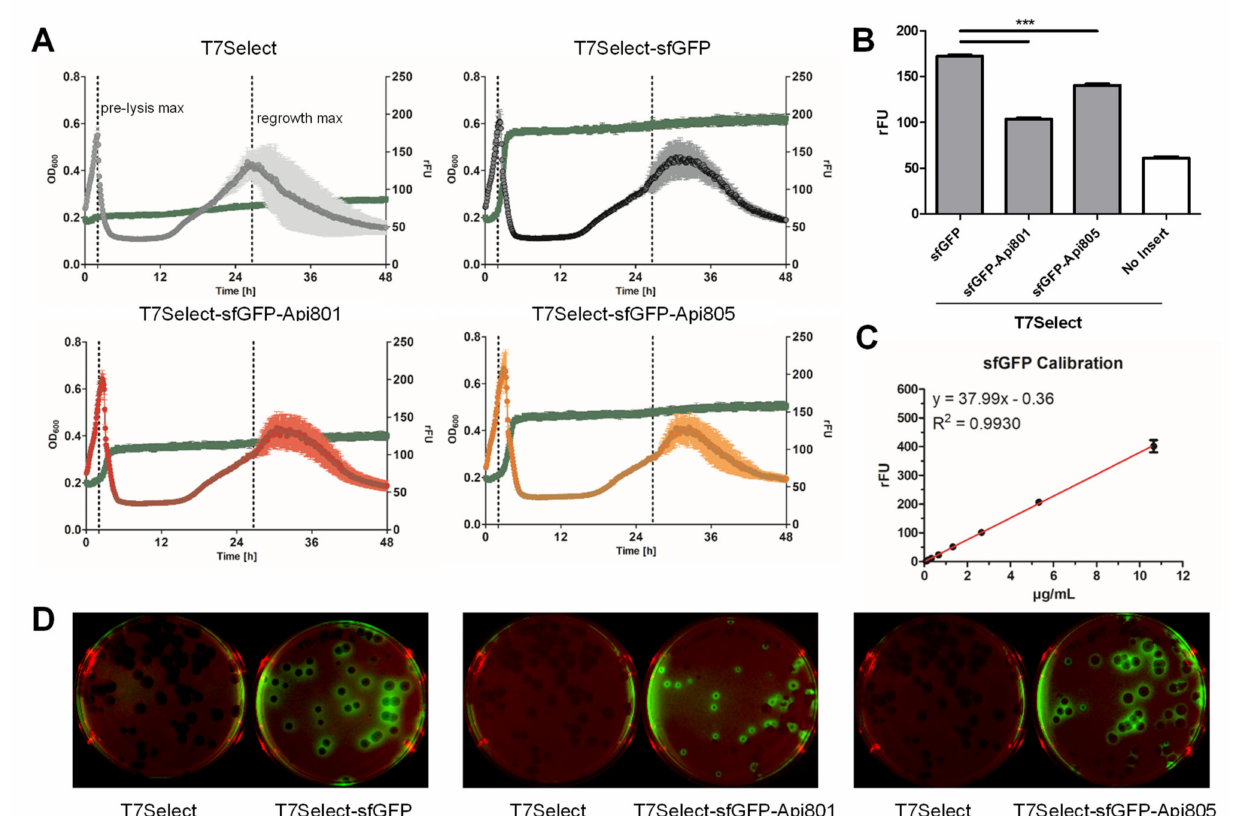
Figure 3. Expression of sfGFP and sfGFP fused to either Api801 or Api805 monitored by the flu- orescence of GFP. ( A ) OD 600 and fluorescence (green curve) of E. coli Rosetta cultures inoculated with T7Select (gray), T7Select-sfGFP (black), T7Select-sfGFP-Api801 (red), or T7Select-sfGFP-Api805 (orange) phages (MOI 0.0625) were monitored every 5 min for 48 h. Dashed lines indicate the maximal OD 600 values before lysis (pre-lysis max) and the highest OD 600 values of the regrowth phase (re- growth max) of T7Select; ( B ) Upper fluorescence plateau obtained for the tested phages. *** p < 0.0001 for T7Select-sfGFP versus T7Select-sfGFP-Api801 or T7Select-sfGFP-Api805. ( A , B ) Experiments were completed twice in quintuplicates. Error bars show the standard deviation of all five replicates of one representative experiment; ( C ) Serial dilution of recombinant sfGFP used to quantify the expressed sfGFP constructs; ( D ) Phage-mediated GFP expression was tested in a plaque assay. A stronger effect was observed for the time to reach the half-maximal fluorescence intensity (EC 50 ) indicating the expression rate of sfGFP (Figure 4C). At the highest con- centration, the EC 50 value of Api802 was 286 min compared to 127 min for the control (no peptide), which is an increase of more than 125%. At a concentration of 64 µ g/mL the EC 50 still increased by 44 min or 34.6%, while the EC 50 values of Api806 and Api810 were similar to the control at all concentrations. This supports the hypothesis that the lysis is delayed by Api802 due to inhibition of phage protein production by blocking the 70S ribosome, which supports the notion that Api802 might be a suitable candidate only when present at lower concentrations. Api806 might still be a promising candidate, as it does not show any adverse effects on phage